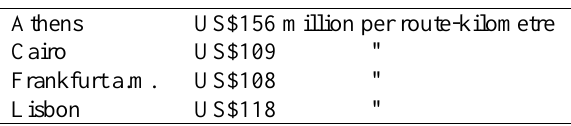
Table 4. UITP data for selected